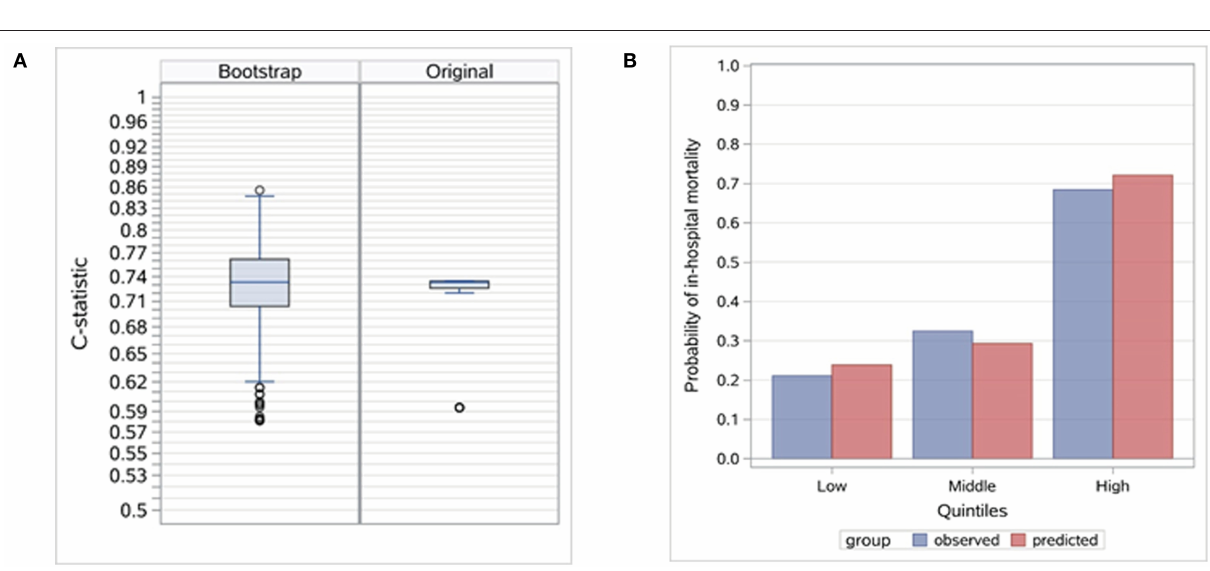
and internally validated Nagelkerke’s R 2 to measure the explained